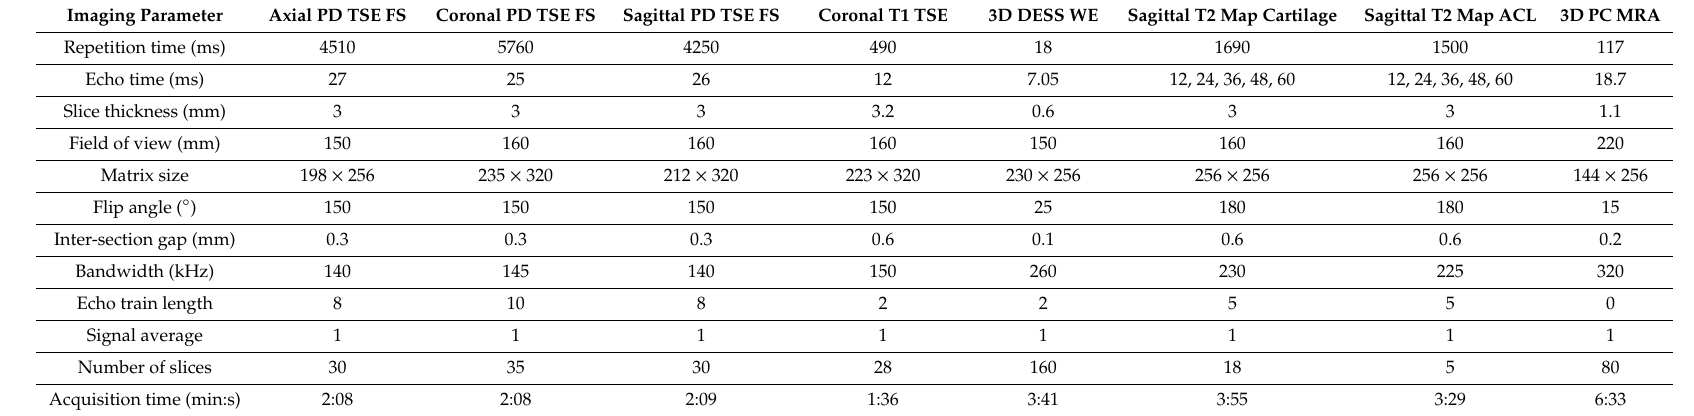
Table 1. Imaging parameters for magnetic resonance imaging sequences used for morphological evaluation of the knee.